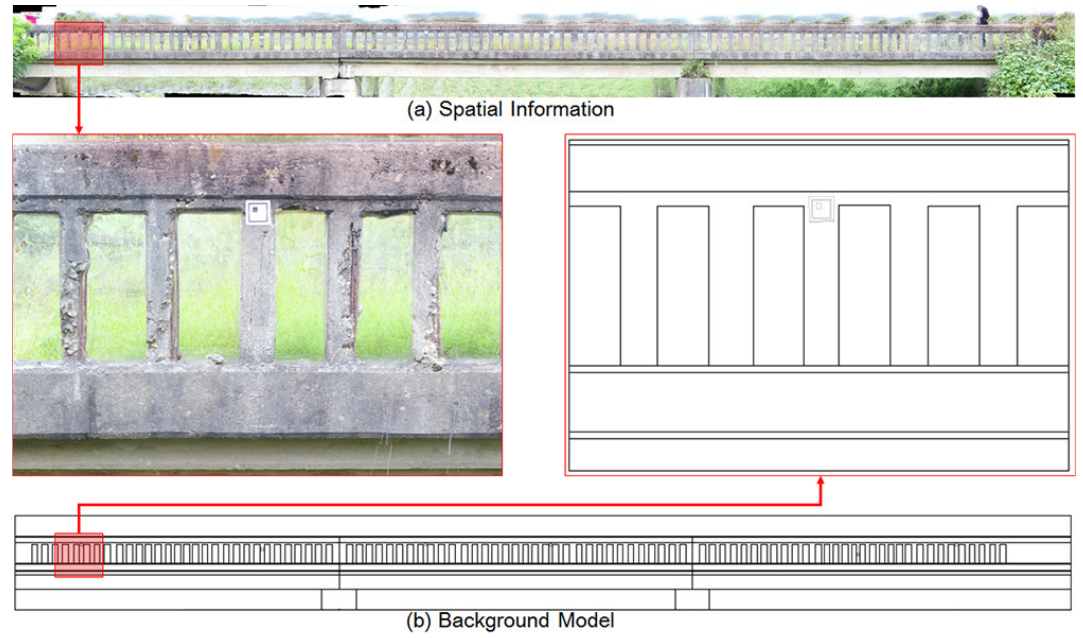
Figure 7. Final results for spatial information and the background